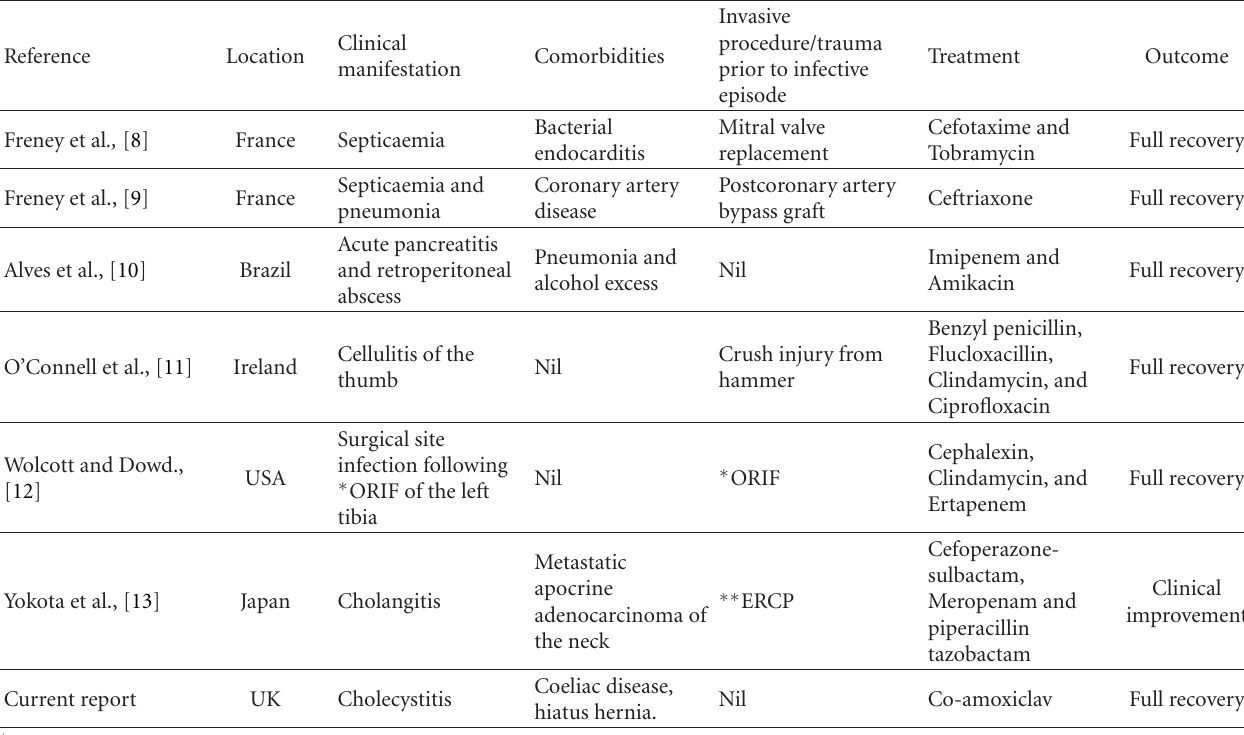
Table 1: Reports on clinical infection by R. planticola in